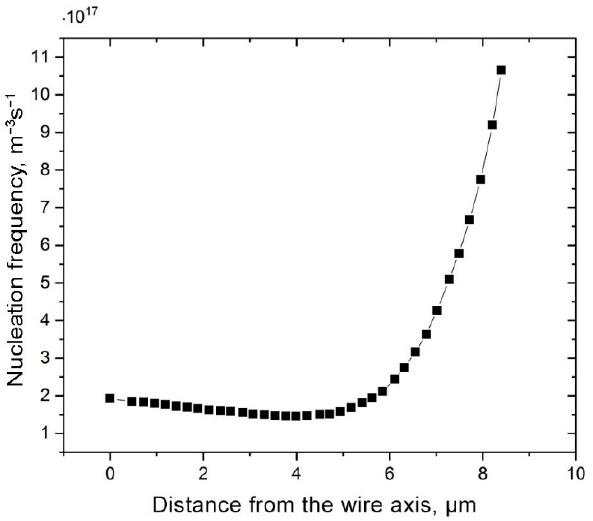
Figure 5. Distribution of nucleation frequency over the microwire radius.